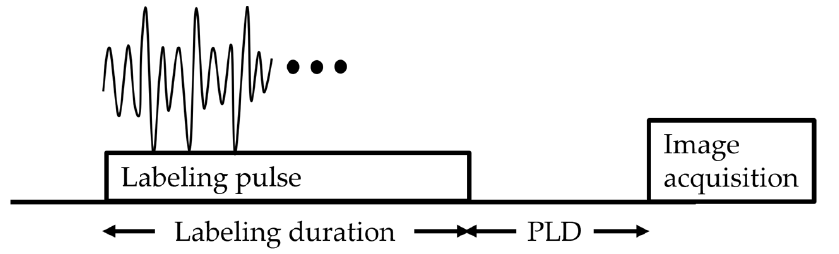
Figure 2. Pseudocontinuous arterial spin labeling diagram. The sequence consists of labeling, fol- followed by a post-labeling delay (PLD), and finally image lowed by a post-labeling delay (PLD), and finally image acquisition.